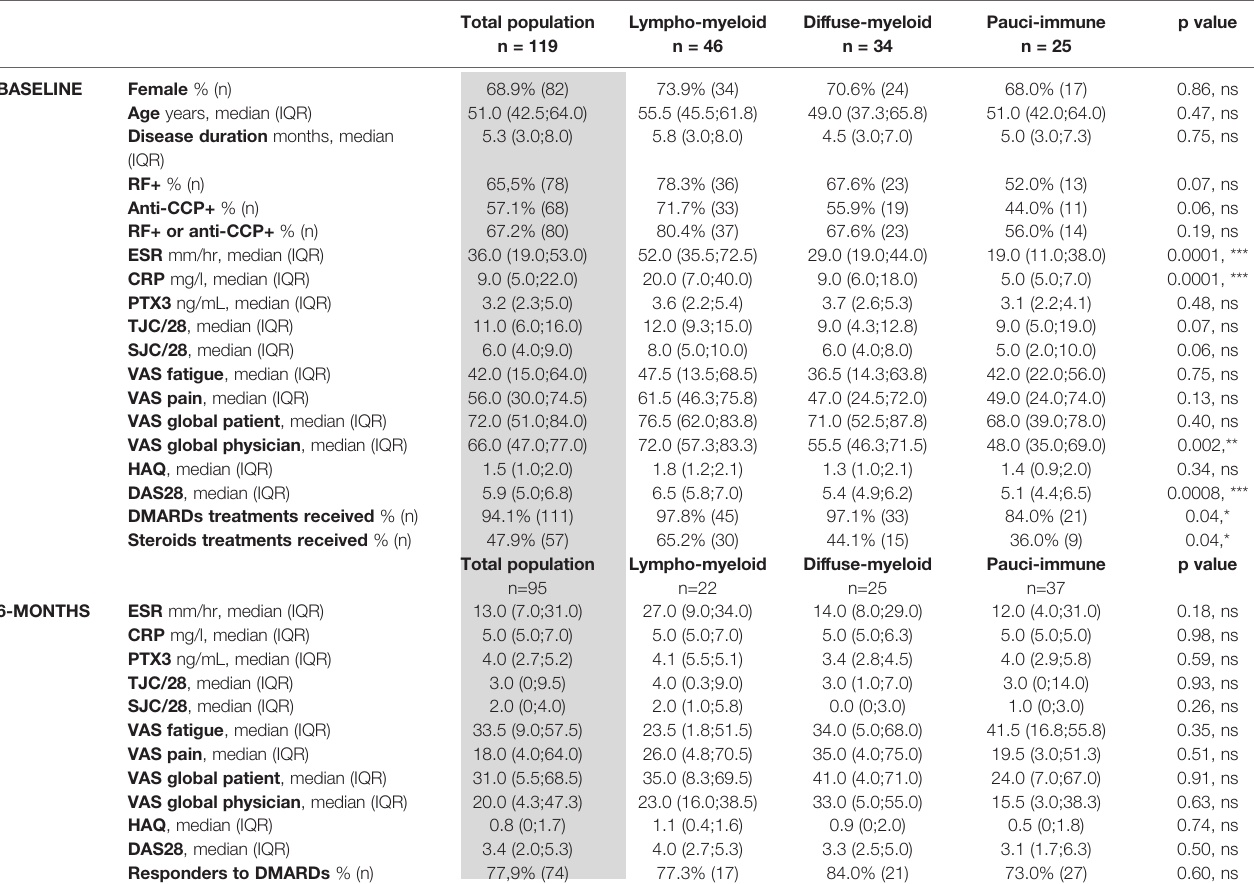
TABLE 1 | Patient ’ s characteristics at baseline and at 6-months after treatment.